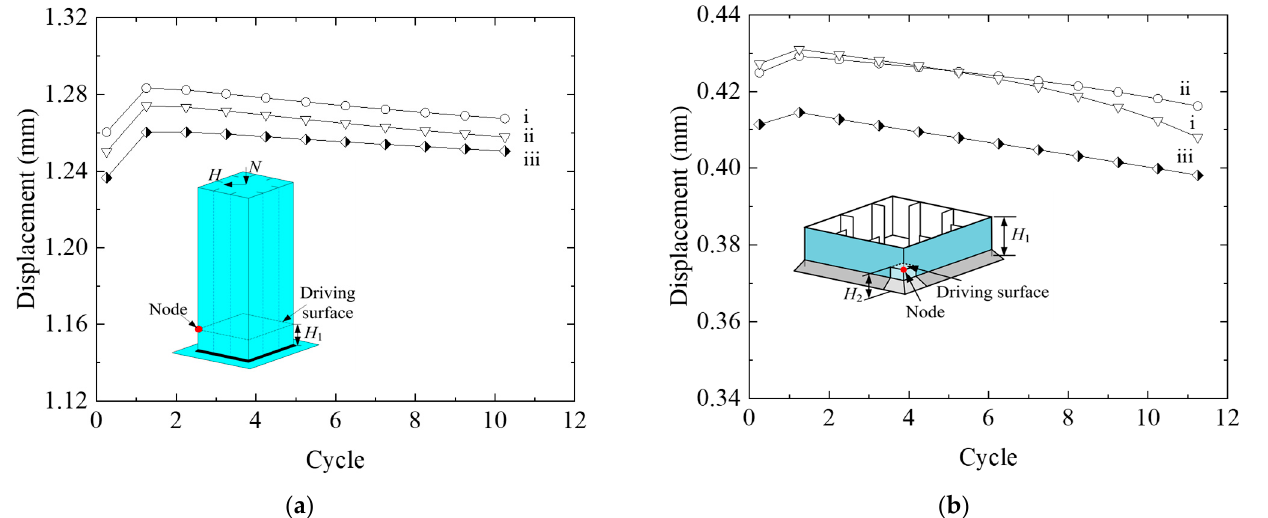
Figure 5. Sensitivity of the mesh size on the numerical results: ( a ) Global model; ( b ) submodel I.